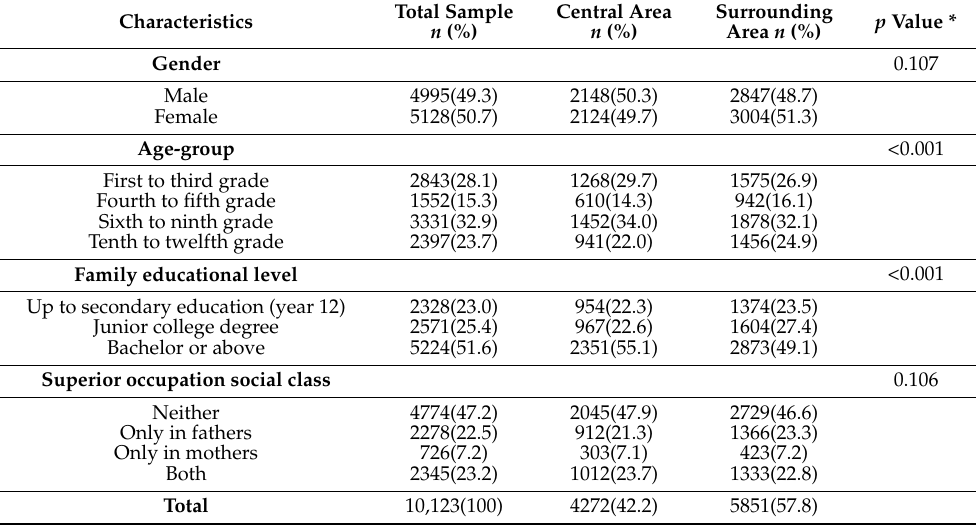
Table 1. Distribution of study subjects by demographic characteristics.